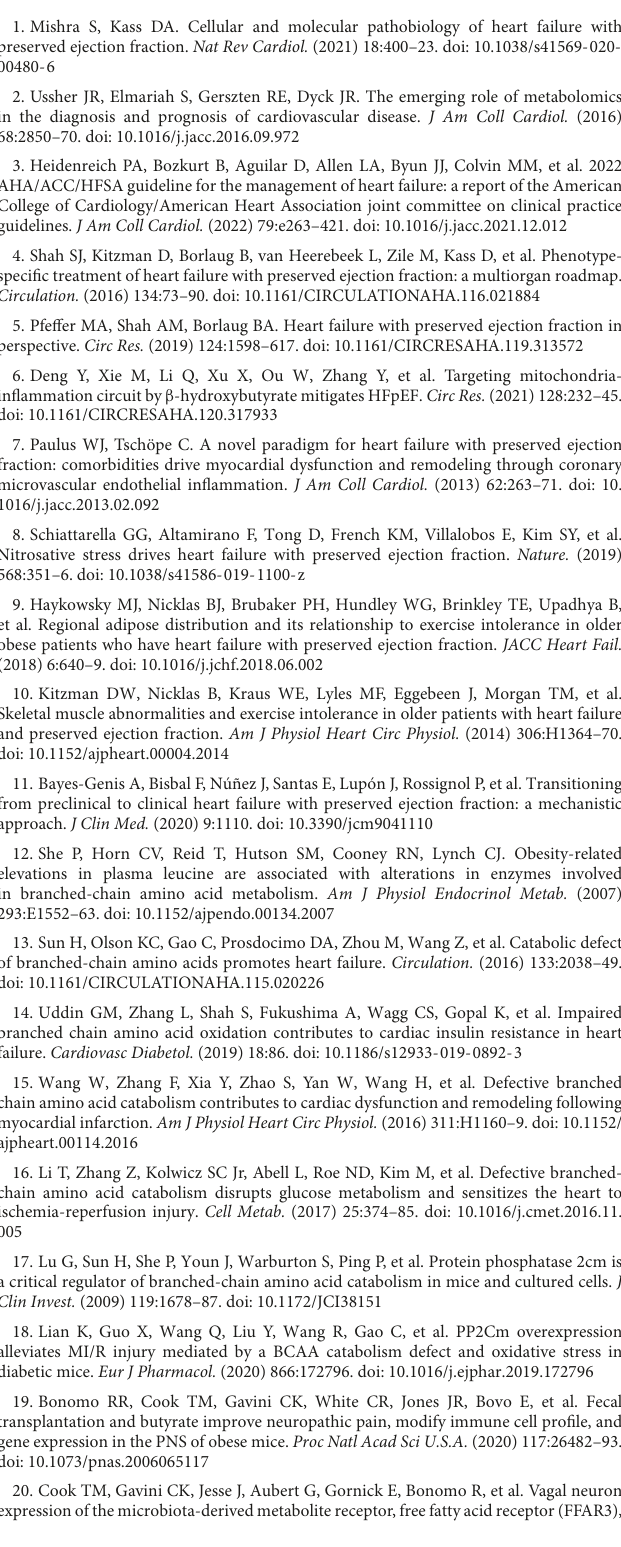
SUPPLEMENTARYTABLE1 Summary table of DEseq2 analysis, data transformed using relative log